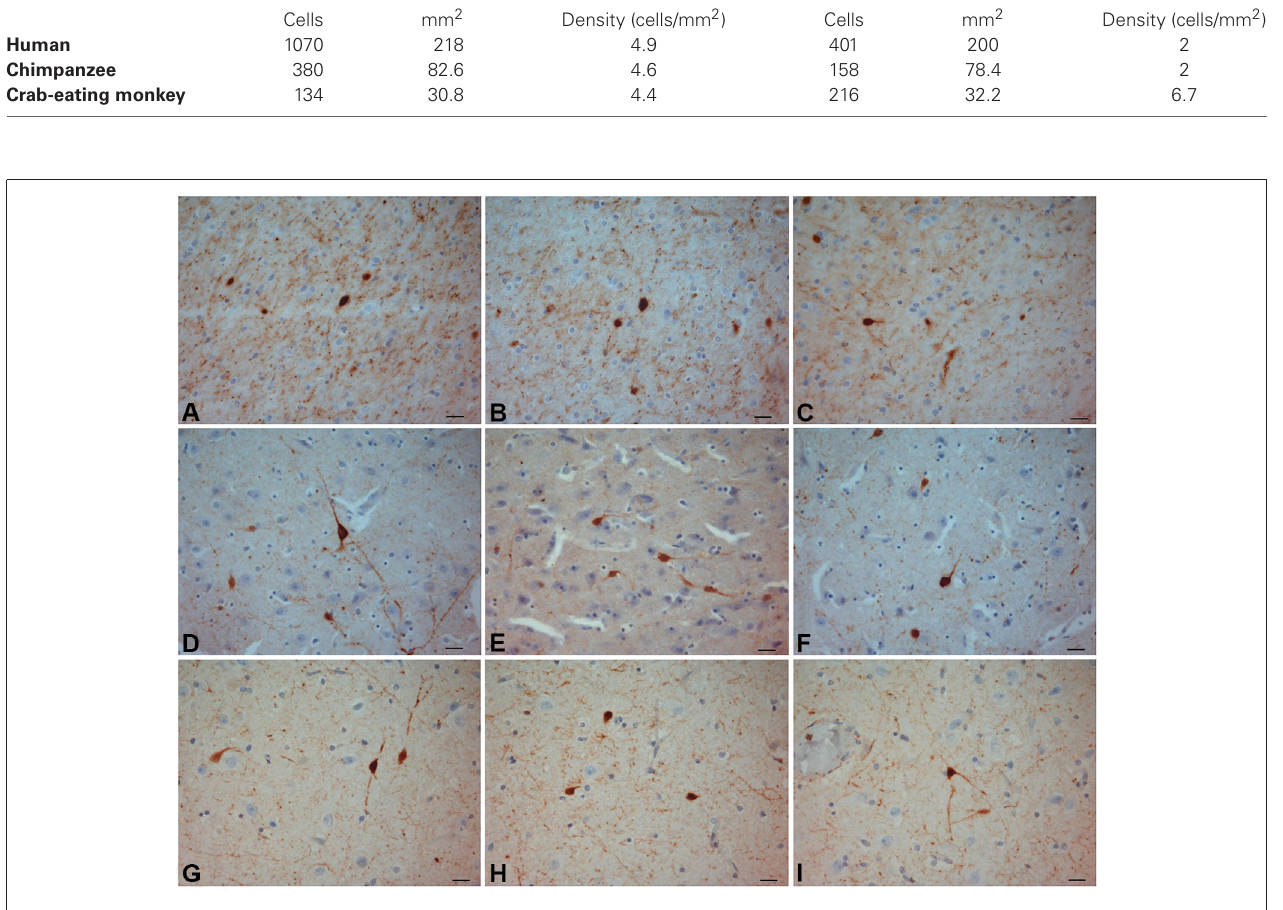
topographically subdivided into dorsal, central and ventral claus- trum (for discussion on the possible subdivisions of the claustrum see Hinova-Palova et al.,